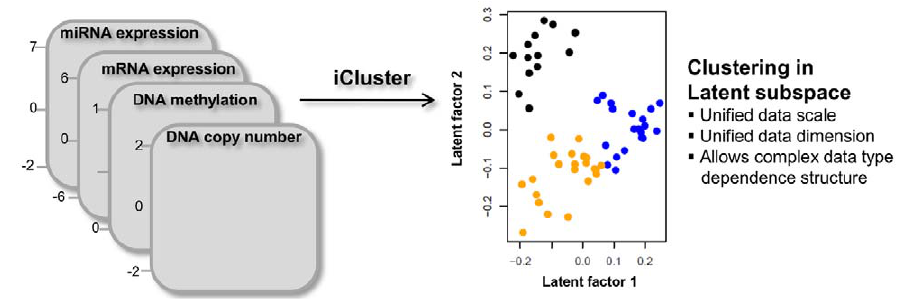
Figure 1. The iCluster framework.